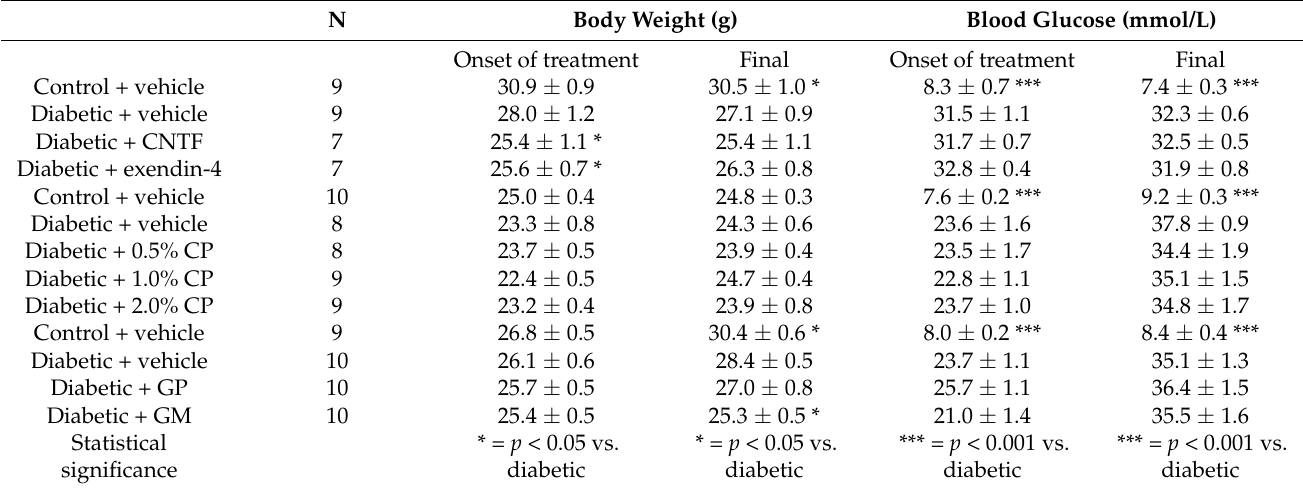
Table 1. General physiological parameters in all